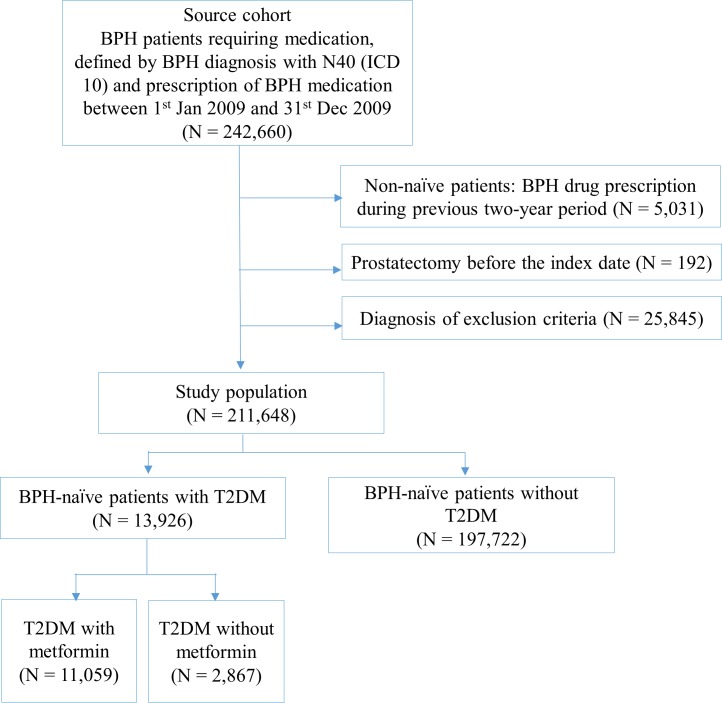
The flowchart for the study design.